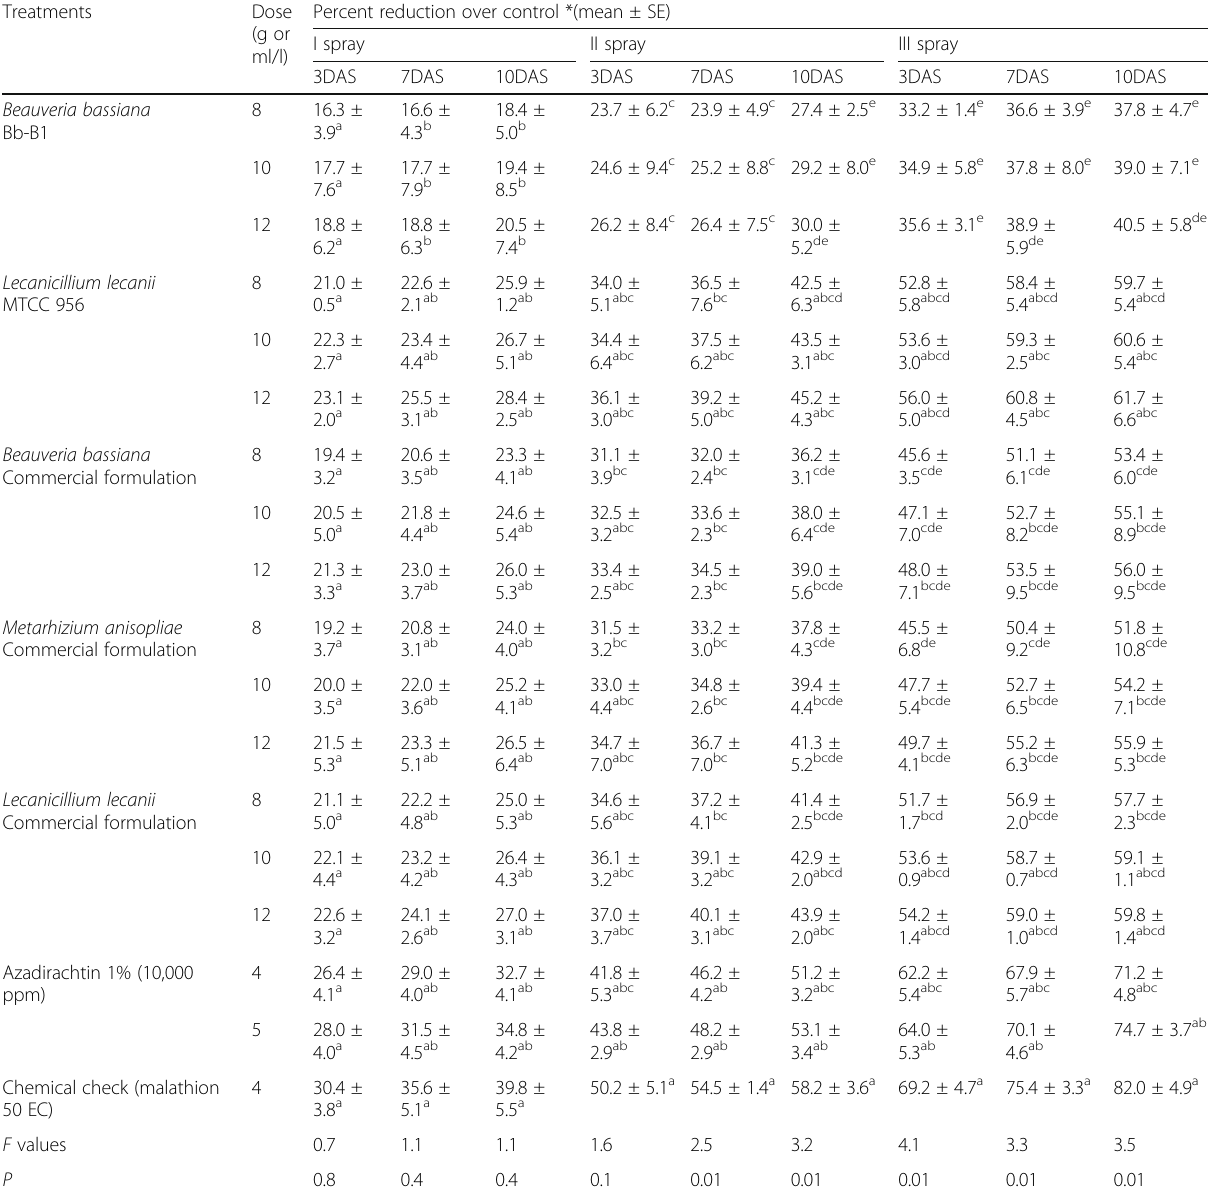
Table 2 Percentage reduction of aphid, Myzus persicae , on capsicum plant treated with indigenous and commercial bioformulations under protected cultivation (2017, 2018)